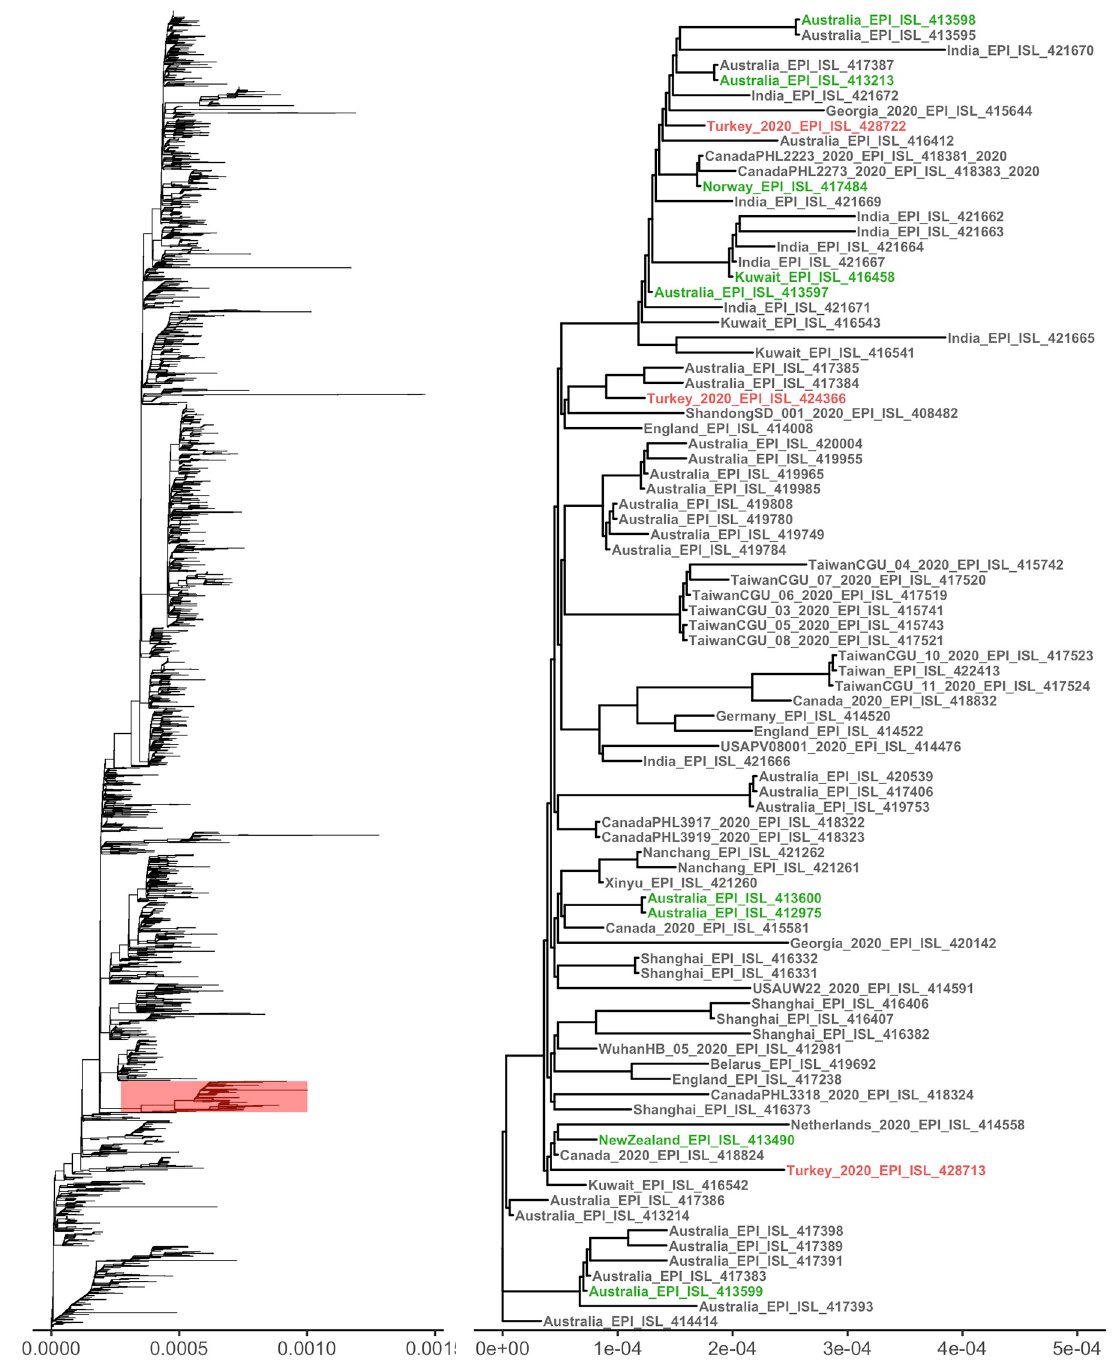
Fig 7. Phylogenetic analysis of the full-length genomes of SARS-CoV-2. (A) A phylogenetic tree of known sequences of SARS-CoV-2 (n = 3970) and the location of our cluster. (B) The sub-tree includes the strain of hCoV-19/Turkey/ERAGEM-001/2020, and other strains from Turkey are highlighted in red. The cases that were known to have G1397A, T28688C, and G29742T mutations and an Iran travel history or direct contact with the Iran travelers are highlighted in green.